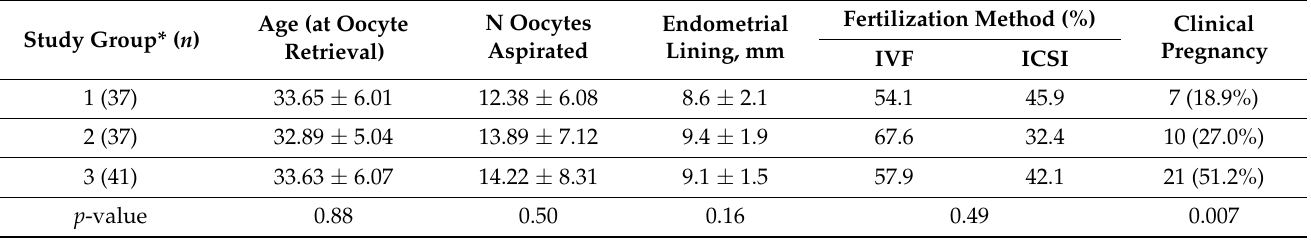
Table 2. Main demographic, clinical and clinical pregnancy data according to study